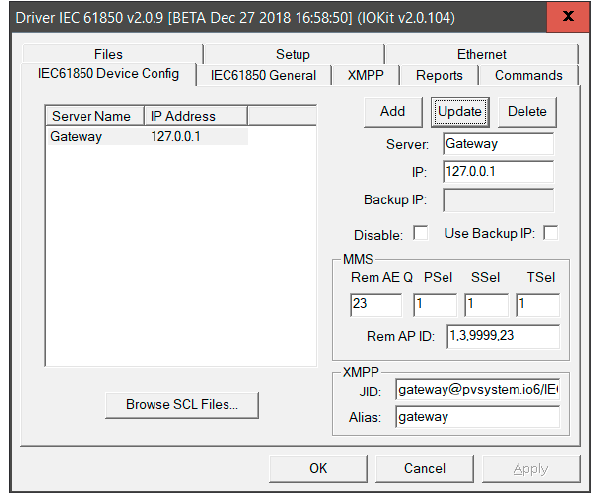
Figure 16. IEC 61850-8-2/XMPP client driver settings.